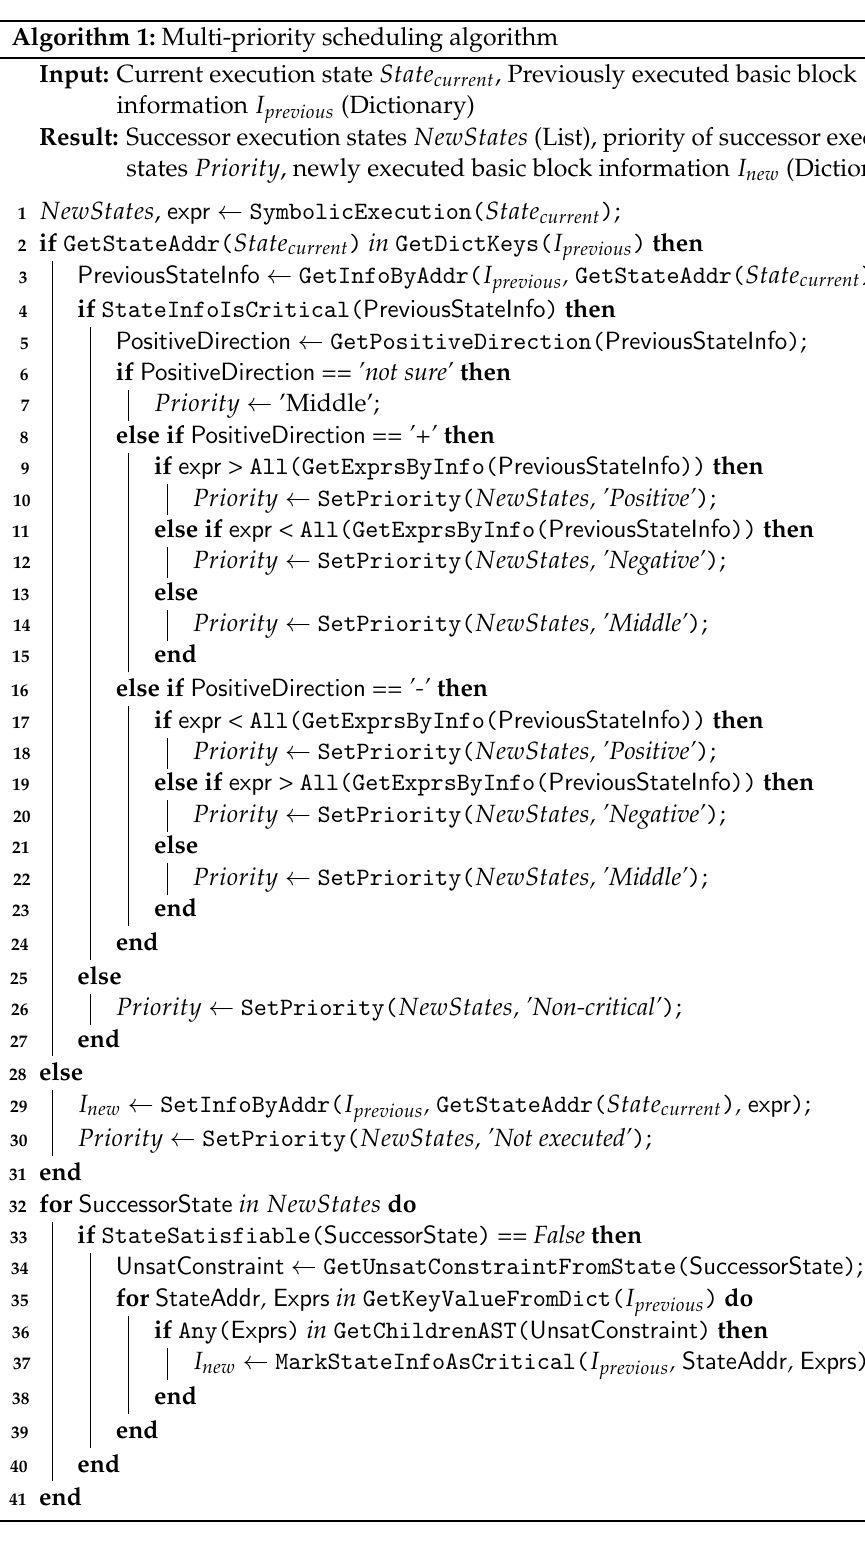
Algorithm 1: Multi-priority scheduling